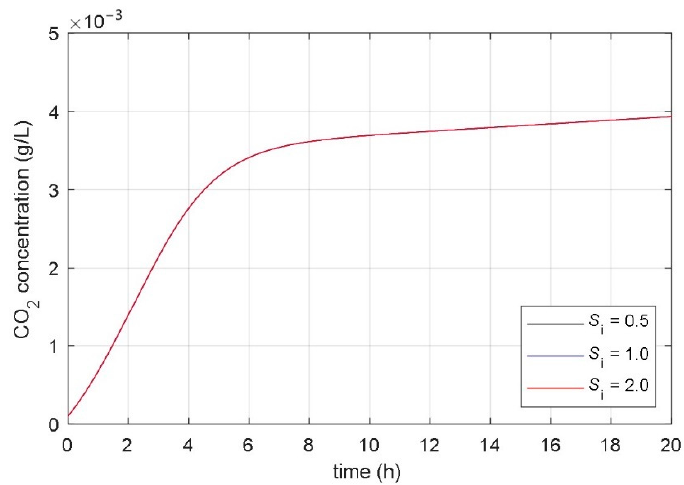
Figure 6. The impact of the substrate saturation constant S m on the time course of the CO 2 concen- tration.